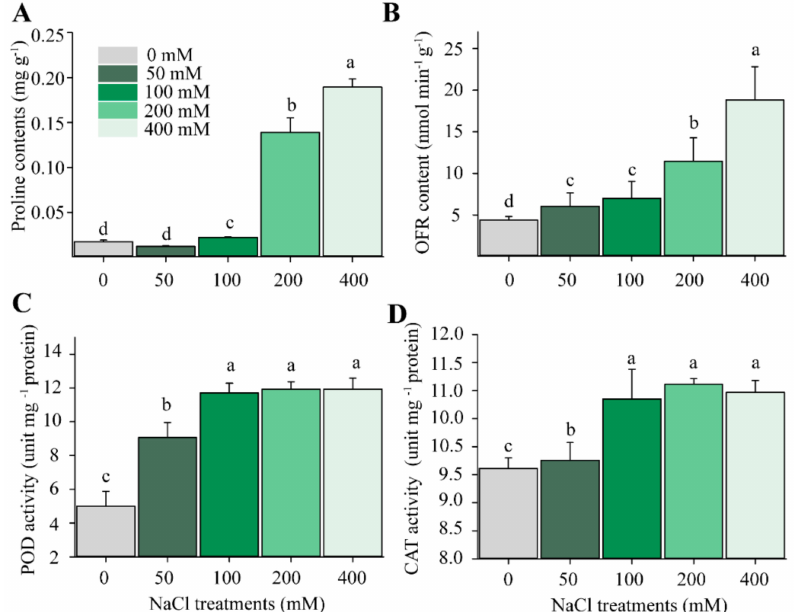
Figure 2. E ff ects of di ff erent salt concentrations on the proline content and activities of antioxidant enzymes in alfalfa. ( A ) Comparison of proline accumulation in alfalfa leaves enduring di ff erent NaCl concentrations for 14 d. ( B – D ) Comparison of contents of oxygen free radicals (OFRs), activities of peroxidase (POD) and activities of catalase (CAT) in alfalfa leaves treated with di ff erent NaCl concentrations for 14 d. One-way ANOVA was used to determine the significant di ff erences among di ff erent NaCl concentrations. Each bar data represents the average ( ± SE) of 3 di ff erent replicates. Di ff erent alphabet letters represent significant di ff erences at p < 0.05 based on one-way ANOVA